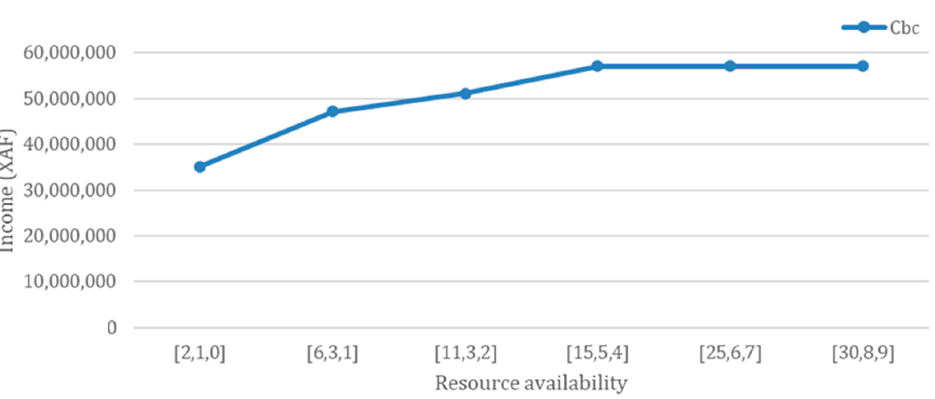
Figure 6. Representation of the solution obtained by Cbc in scenario 3. Onion is cultivated once on plots 1 and 4, and twice on plots 2 and 3. Carrot is cultivated once on plot 4, thrice on plot 1 and four times on plots 2 and 3. Tomato is cultivated once on plot 3, twice on plots 2 and 4, and thrice on plot 1. Finally, broccoli is cultivated twice only on plot 4.